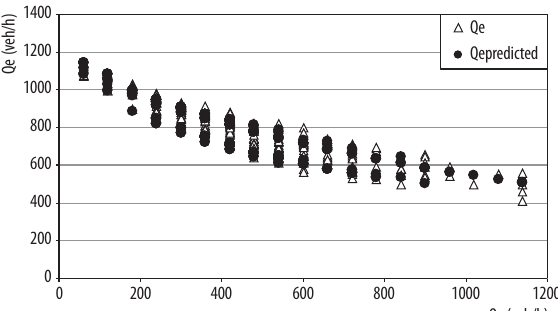
Table 2. Results of regression analysis for single-lane traffi c circle Observation Area